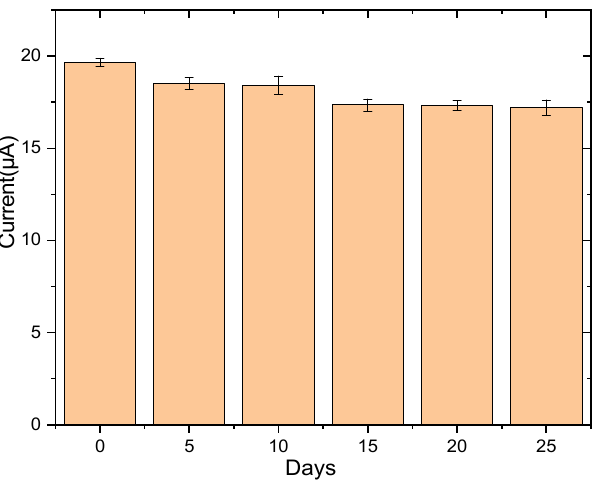
Figure 13. Responses obtained from the MIP-GCE/OPPy/CuNPs sensor in H 2 SO 4 solution contain- ing 10 − 6 mol L − 1 of SDZ.